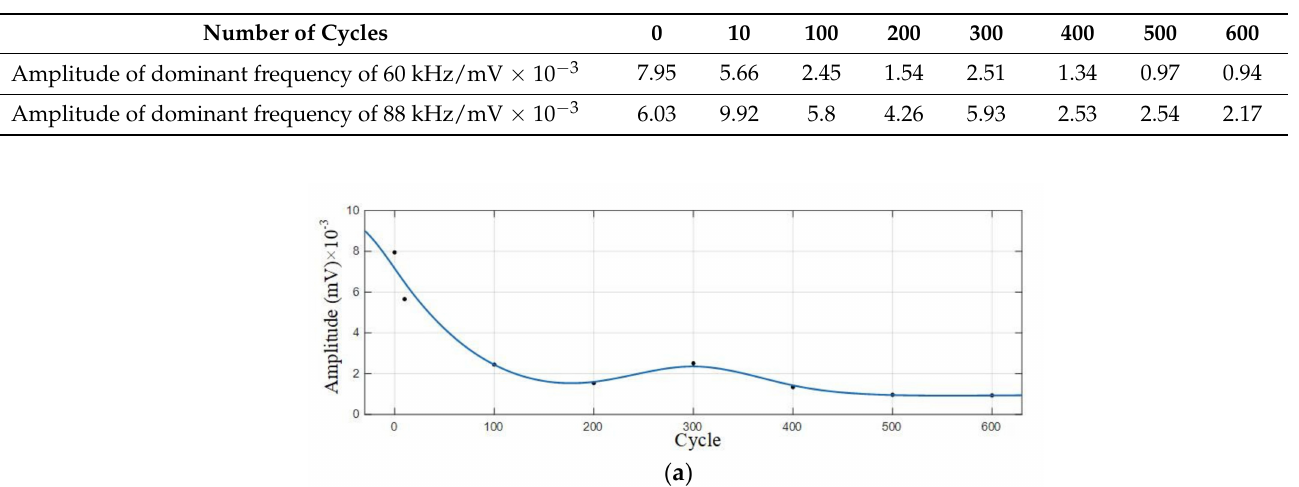
Table 6. Amplitude information of acoustic emission signals of Group B batteries during discharge.